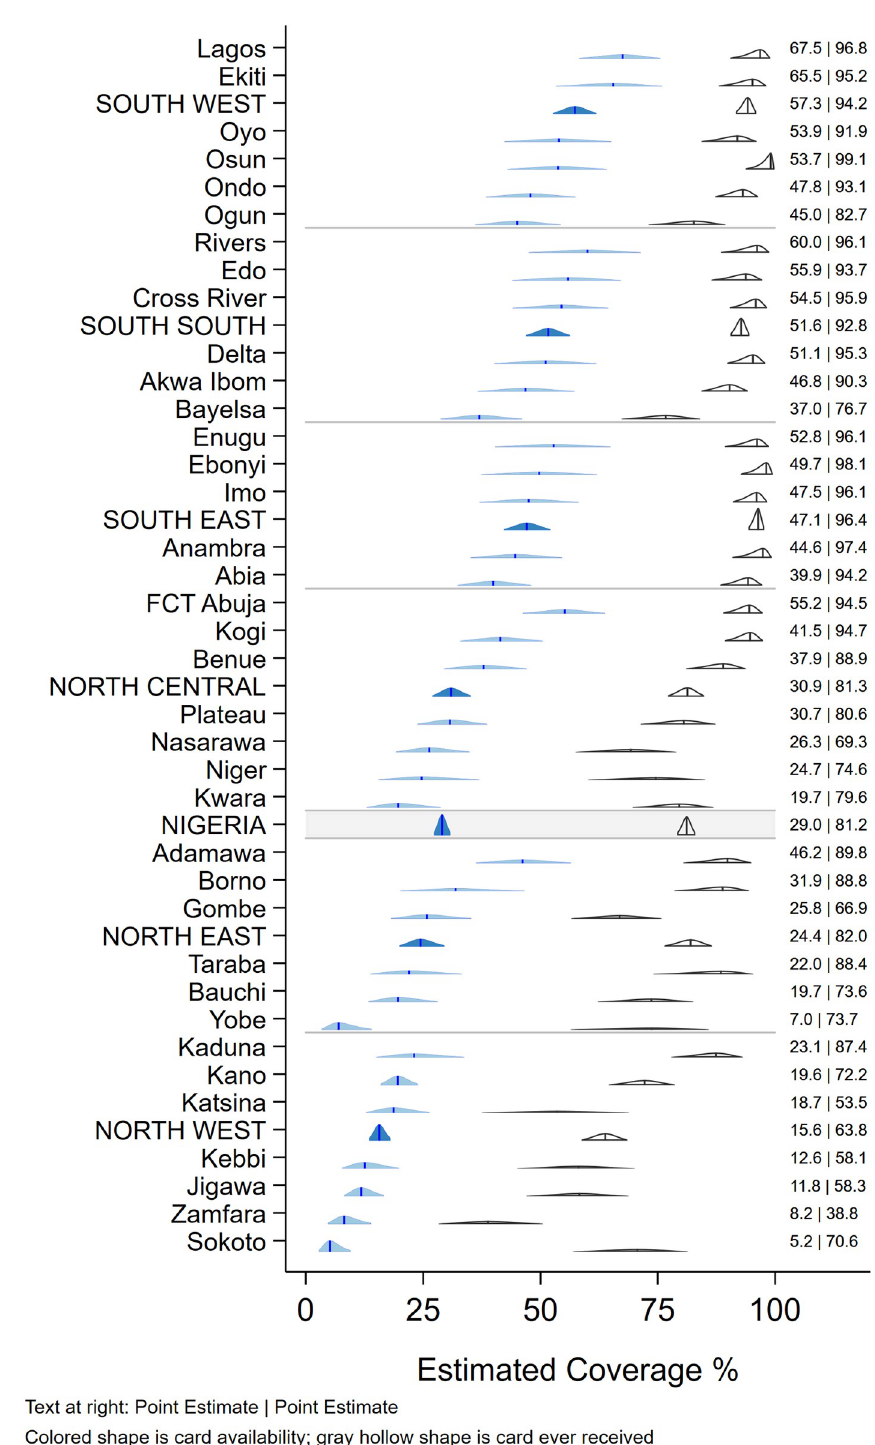
Fig 1. Weighted percentage of children aged 12–23 months who were reported to have ever received a card and whose card was seen during the survey, Nigeria MICS/NICS 2016–17.